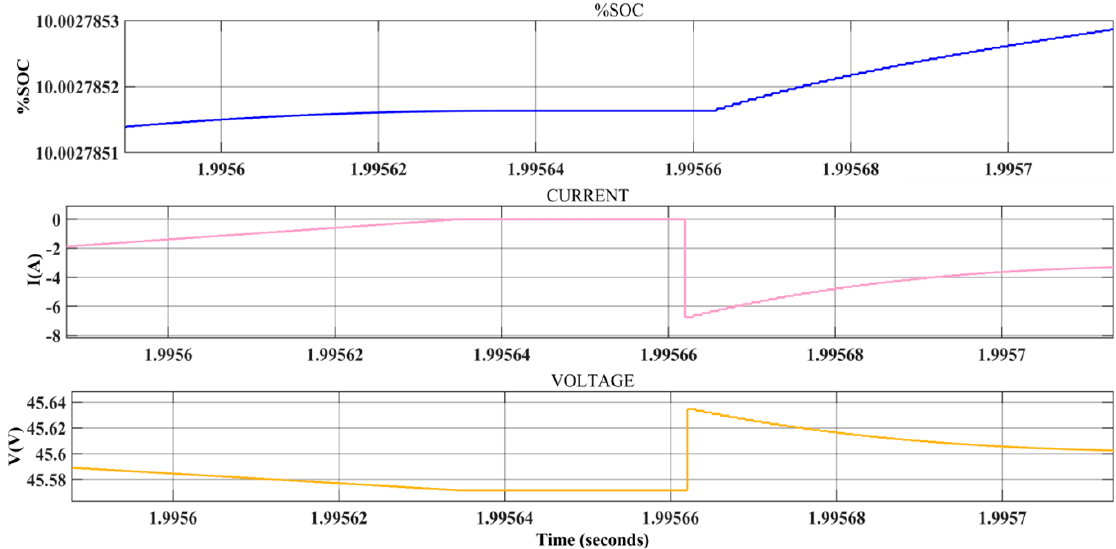
Figure 10. Battery waveforms: state of charge (SOC), voltage and current. When the PV source is connected to the Zeta part of the MPC with a load connected to the output, the inductor L 1 is initially charged to a value equal to the input voltage of the PV with 40 V. Later it discharged to − 40 V. With the MPC working in continuous conduction mode, the current through the inductor L 1 is continuous as shown in Figure 11.